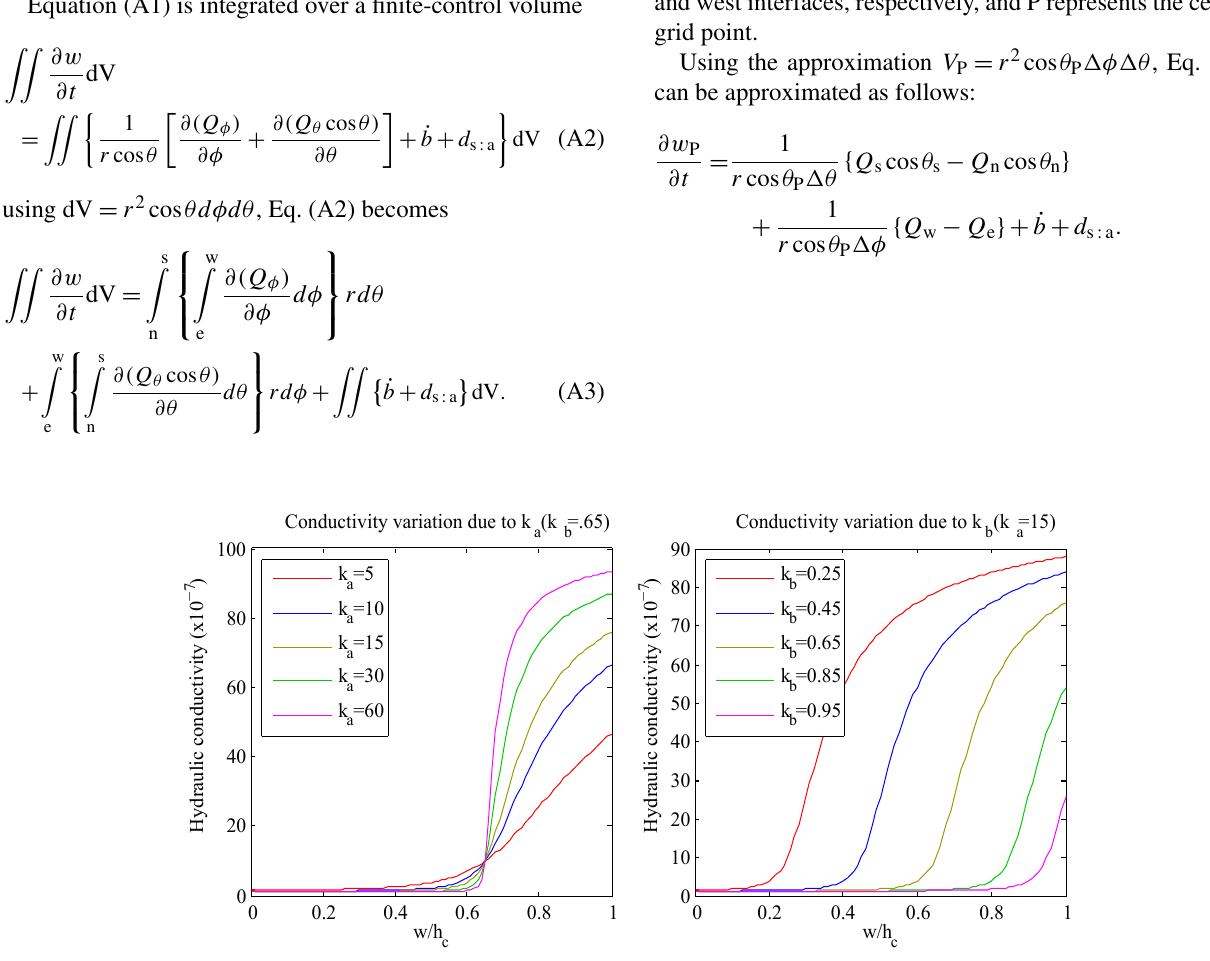
Figure A1. Variations of subglacial hydraulic conductivity, K , with respect to changes in hydraulic parameters k a and k b for values of K ranging between 1 . 0 × 10 − 7 and 1 . 0 × 10 − 5